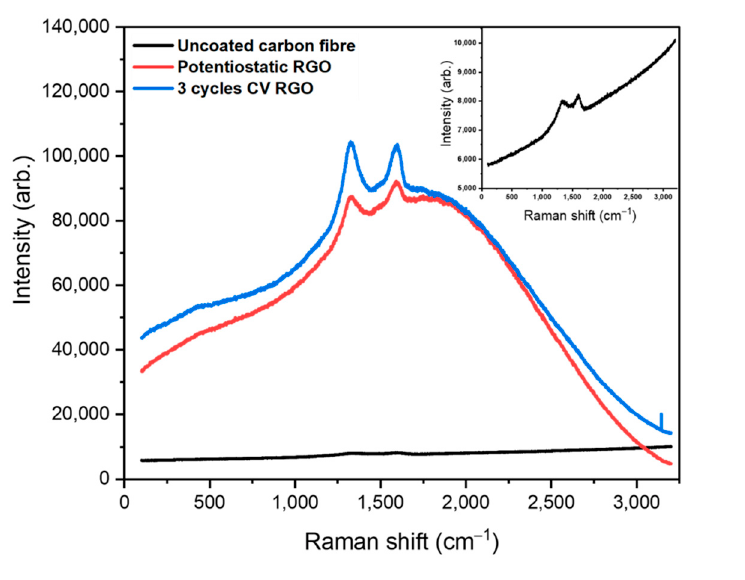
Figure 2. Raman spectrum (obtained using a 785 nm laser) of uncoated carbon fibre (black), carbon fibre coated with rGO by potentiostatic deposition (red) and carbon fibre coated with rGO using 3 CV cycles